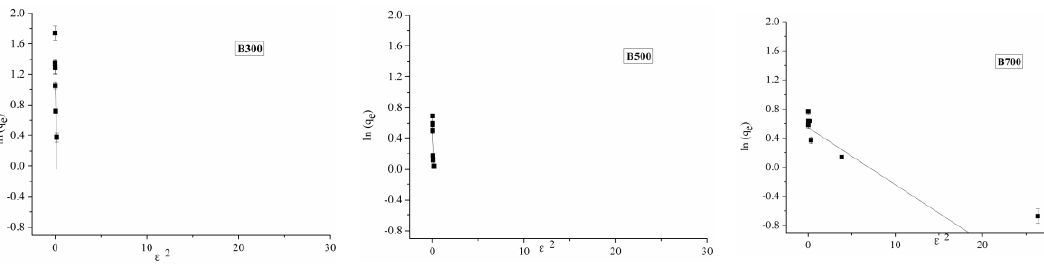
Figure 4. The fitting curve of the adsorption isotherm using Dubinin-Radushkevitch (D-R) models. Table 4. The fate of CP after application to the biochars.